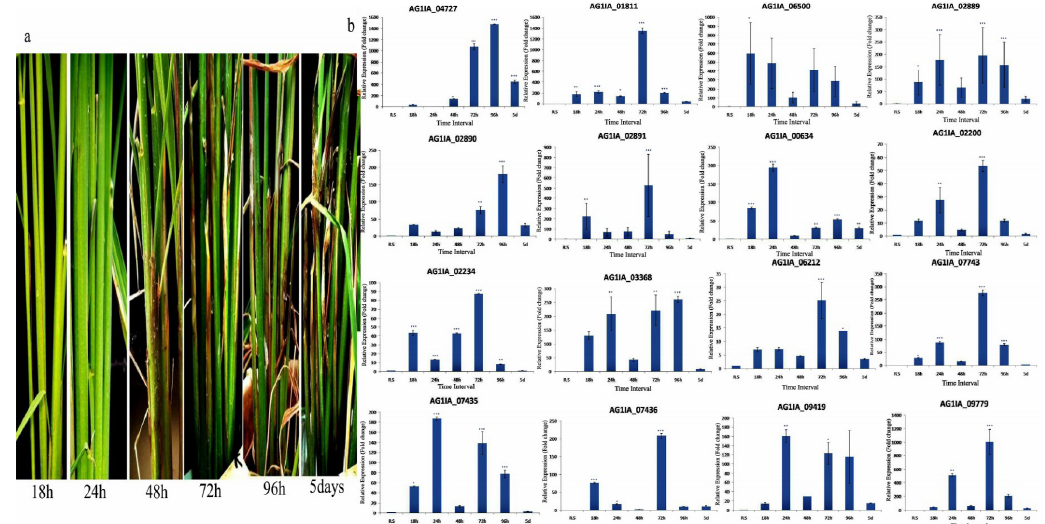
Figure 5. (a) Disease symptoms of R. solani Wgl-2 infection in susceptible rice cultivar TN1 after 18 h, 24 h, 48 h, 72 h, 96 h, and 5 days of inoculation. Clear visible sheath blight disease symptoms were observed only after 72 h of inoculation. ( b) qRT-PCR expression analysis of 16 pectin degrading (PD) genes (polygalacturonases and pectinesterases) at different time points after fungal inoculation. X-axis: samples (R.s: R. solani cultured in potato dextrose agar medium, 18 h to 5 d: R.solani inoculated sheath tissue of TN1 harvested at different time points); Y-axis: Expression level of the individual PD genes relative to their expression in R. solani grown in PDA. Error bars indicate the mean ± S.E. of three biological replicates. Statistical significance was determined by performing one-way ANOVA analyses followed by a Tukey’s test (*= p <0.01, **= p <0.001, and ***= p <0.0001).